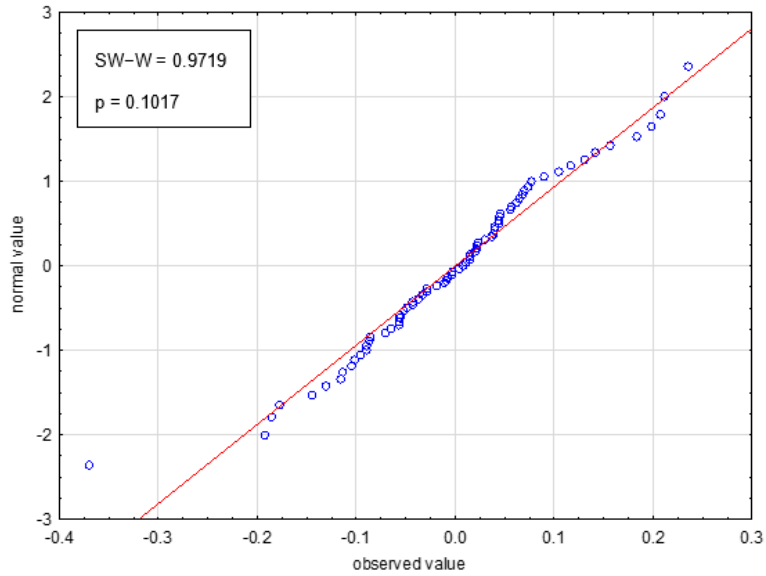
Figure 3. Residual normality plot for the optimal model.